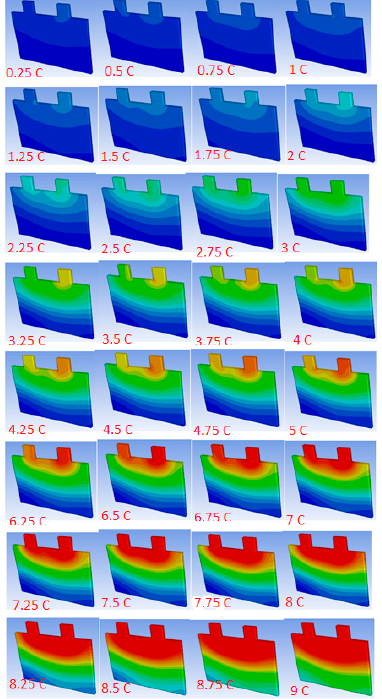
Figure 14. Temperature distribution of the battery cell at different discharge rates from 0.25 C to 9 C.